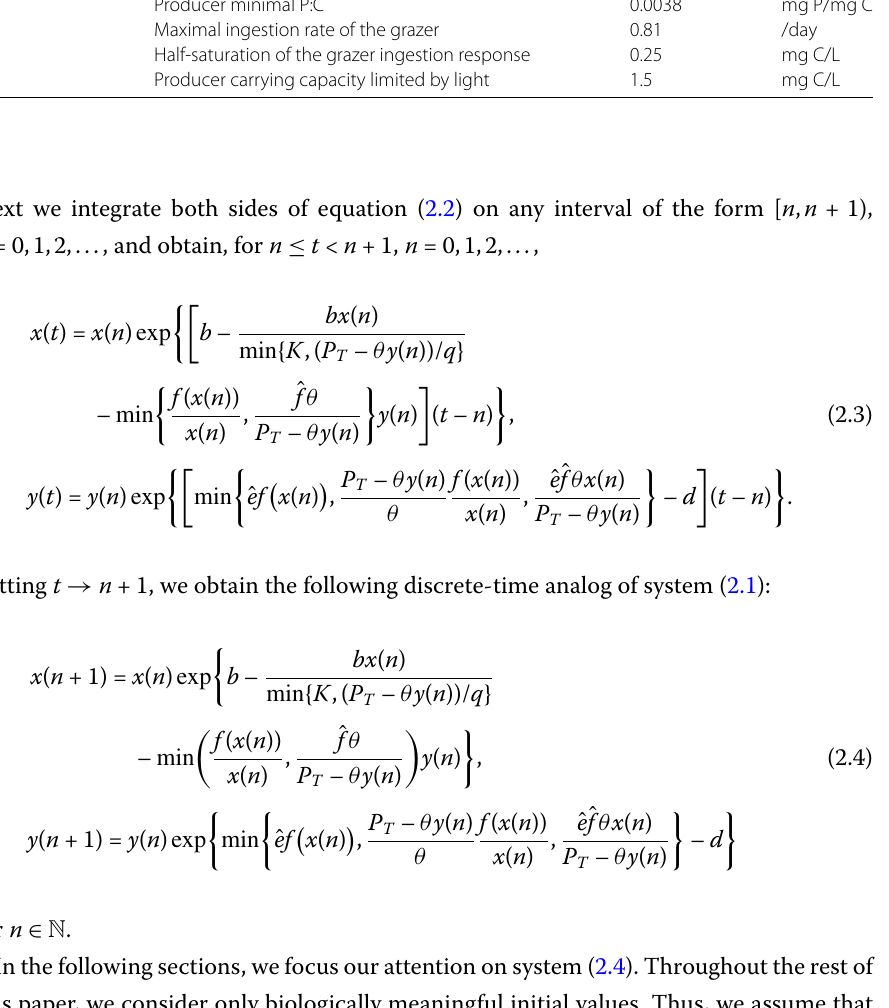
Table 1 Parameters of model (2.4) with default values Parameter Value Unit P T Total phosphorus 0–0.14 mg P/L ˆ e Maximal production efficiency of the grazer 0.8 – b Maximal growth rate of the producer 1.2 /day d Grazer loss rate (include respiration) 0.25 /day θ Grazer constant P:C 0.03 mg P/mg C q Producer minimal P:C 0.0038 mg P/mg C c Maximal ingestion rate of the grazer 0.81 /day a Half-saturation of the grazer ingestion response 0.25 mg C/L K Producer carrying capacity limited by light 1.5 mg